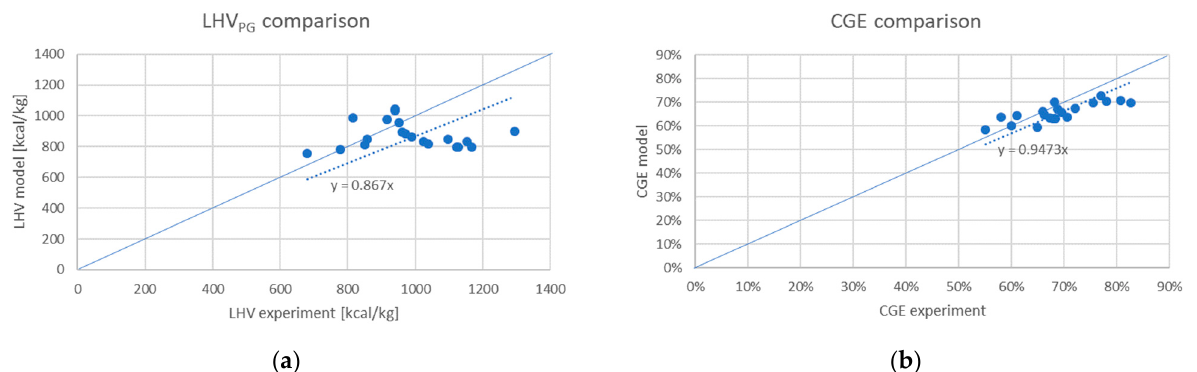
Figure 9. Comparison between experimental results with regression model (a) LHV PG , (b) CGE.